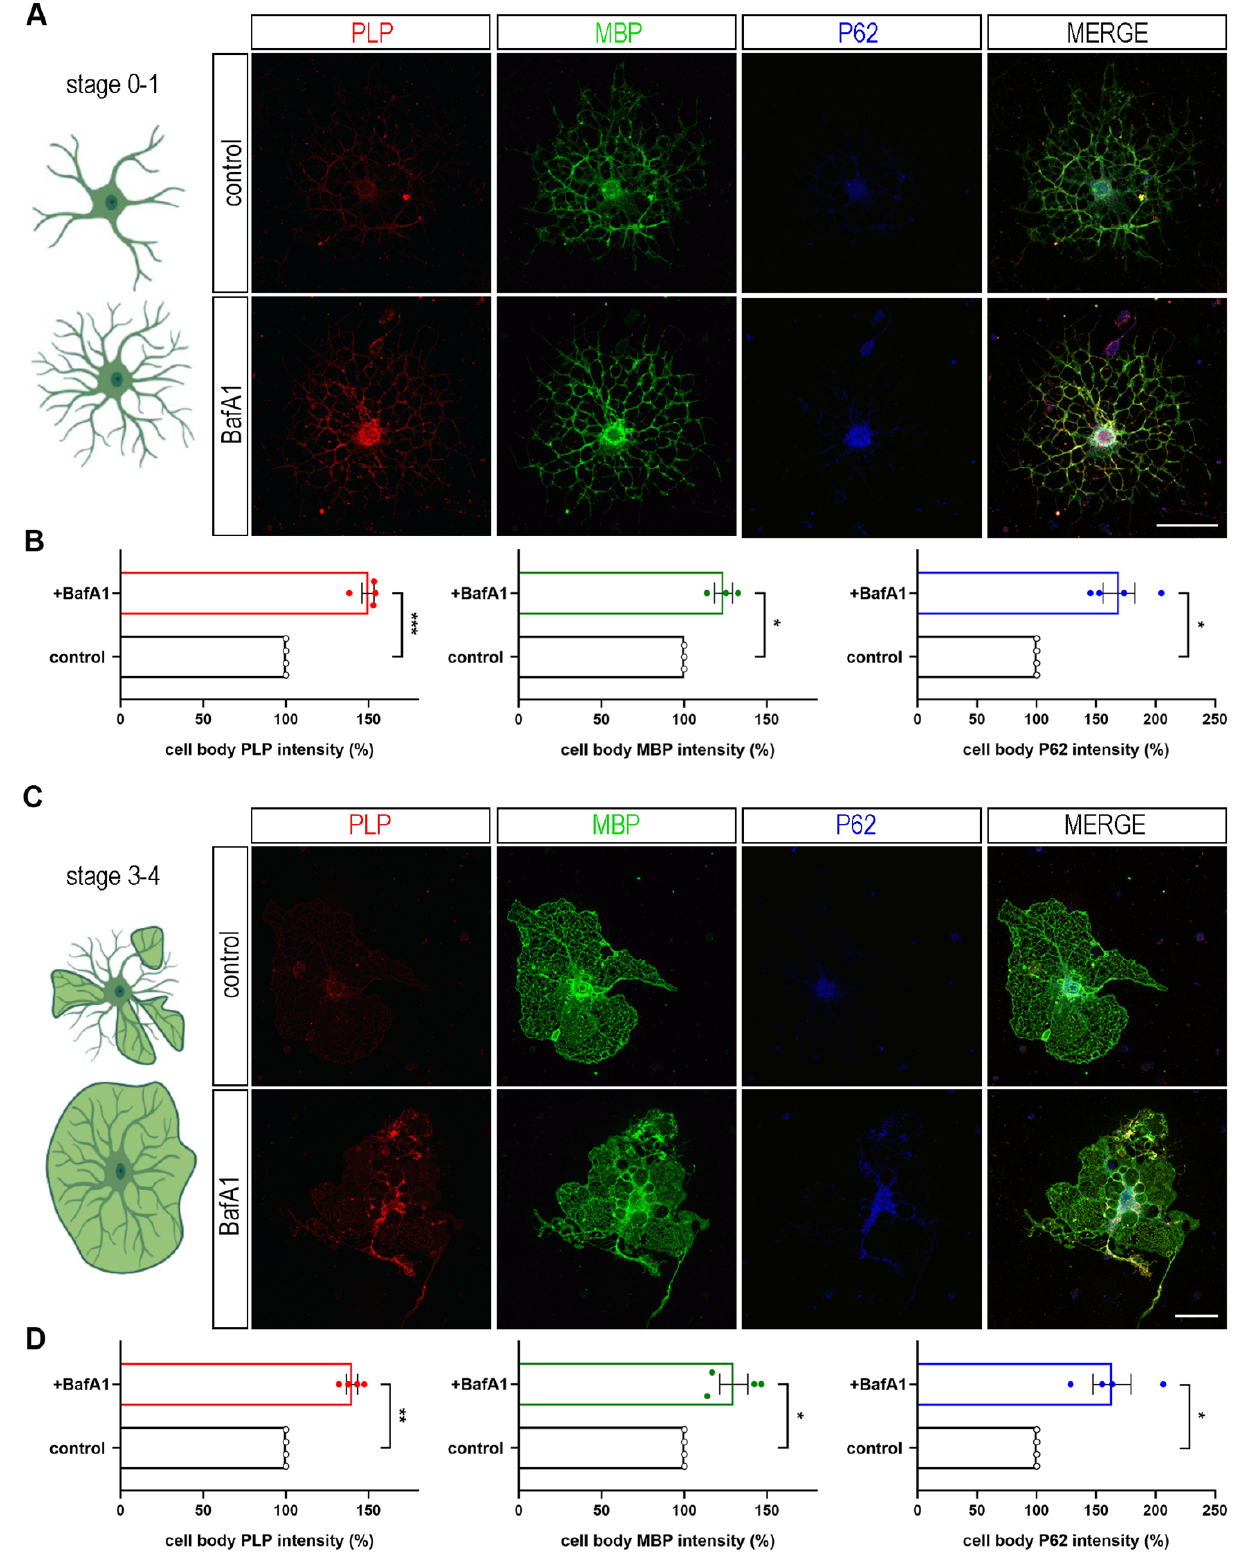
FIGURE 4: PLP and MBP constitute autophagic cargoes. A, C. Confocal images of DIV2 primary OLs, stage 0-1(A) and stage 3-4 (C), immuno- labeled for PLP (red), MBP (green) and P62 (blue). Cells were either vehicle treated (control), or treated for 4 h with 10nM BafilomycinA1 (BafA1). B, D. Quantification of the normalized intensity levels of the above-mentioned proteins. Data information: Data are shown as mean ± SEM. N=4 independent experiments. 120-170 cells of stage 0-1 (B) and 40-50 cells of stage 3-4 (D) were used for the analysis. Student’s t-test was used to determine statistical significance. *p < 0.05, **p ≤ 0.01, ***p ≤ 0.001. Scale bars: 30 OPEN ACCESS | www.cell-stress.com 99 Cell Stress | DECEMBER 2022 | Vol. 6 No. 12